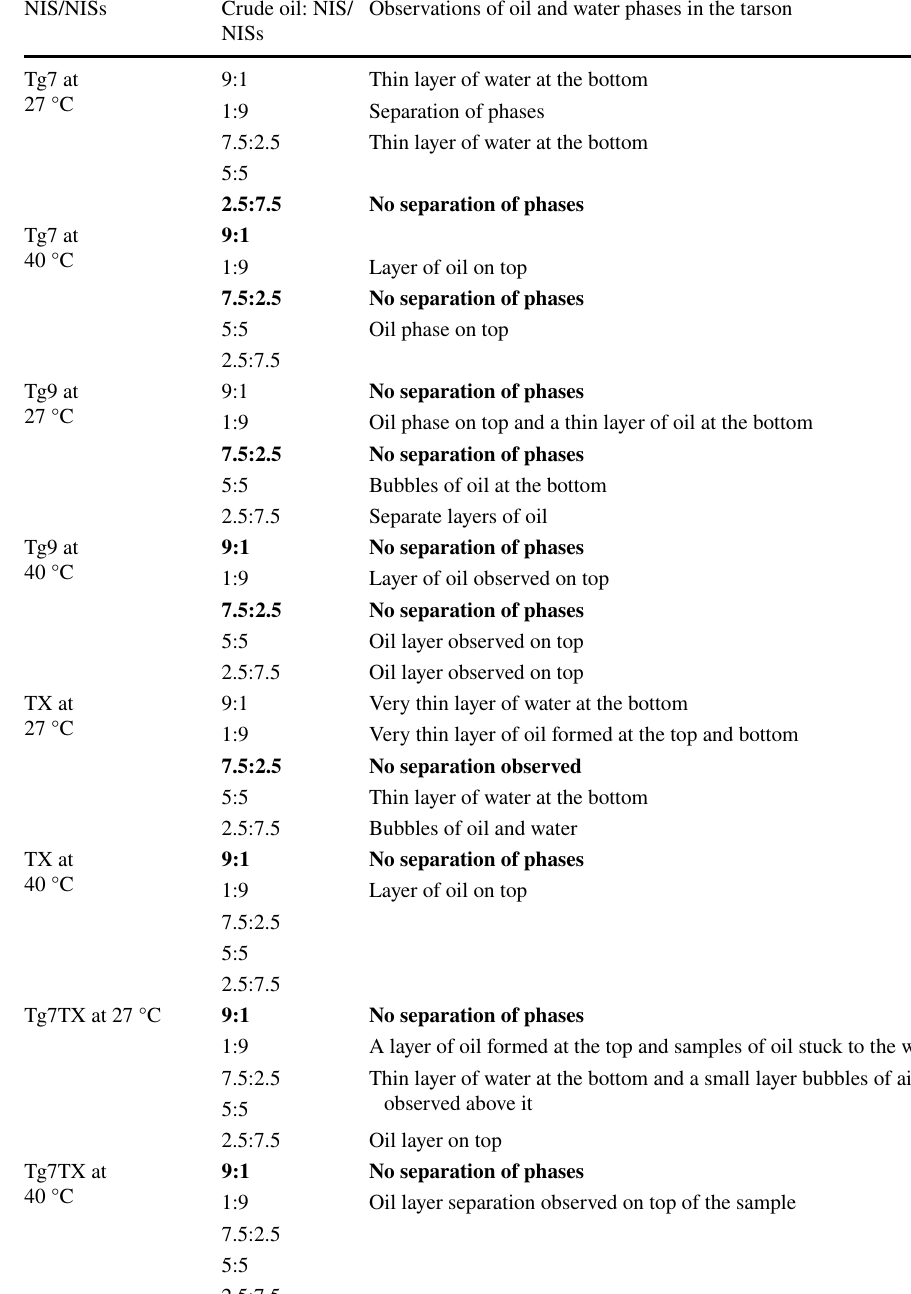
Table 7 Table showing the emulsion stability of NIS or